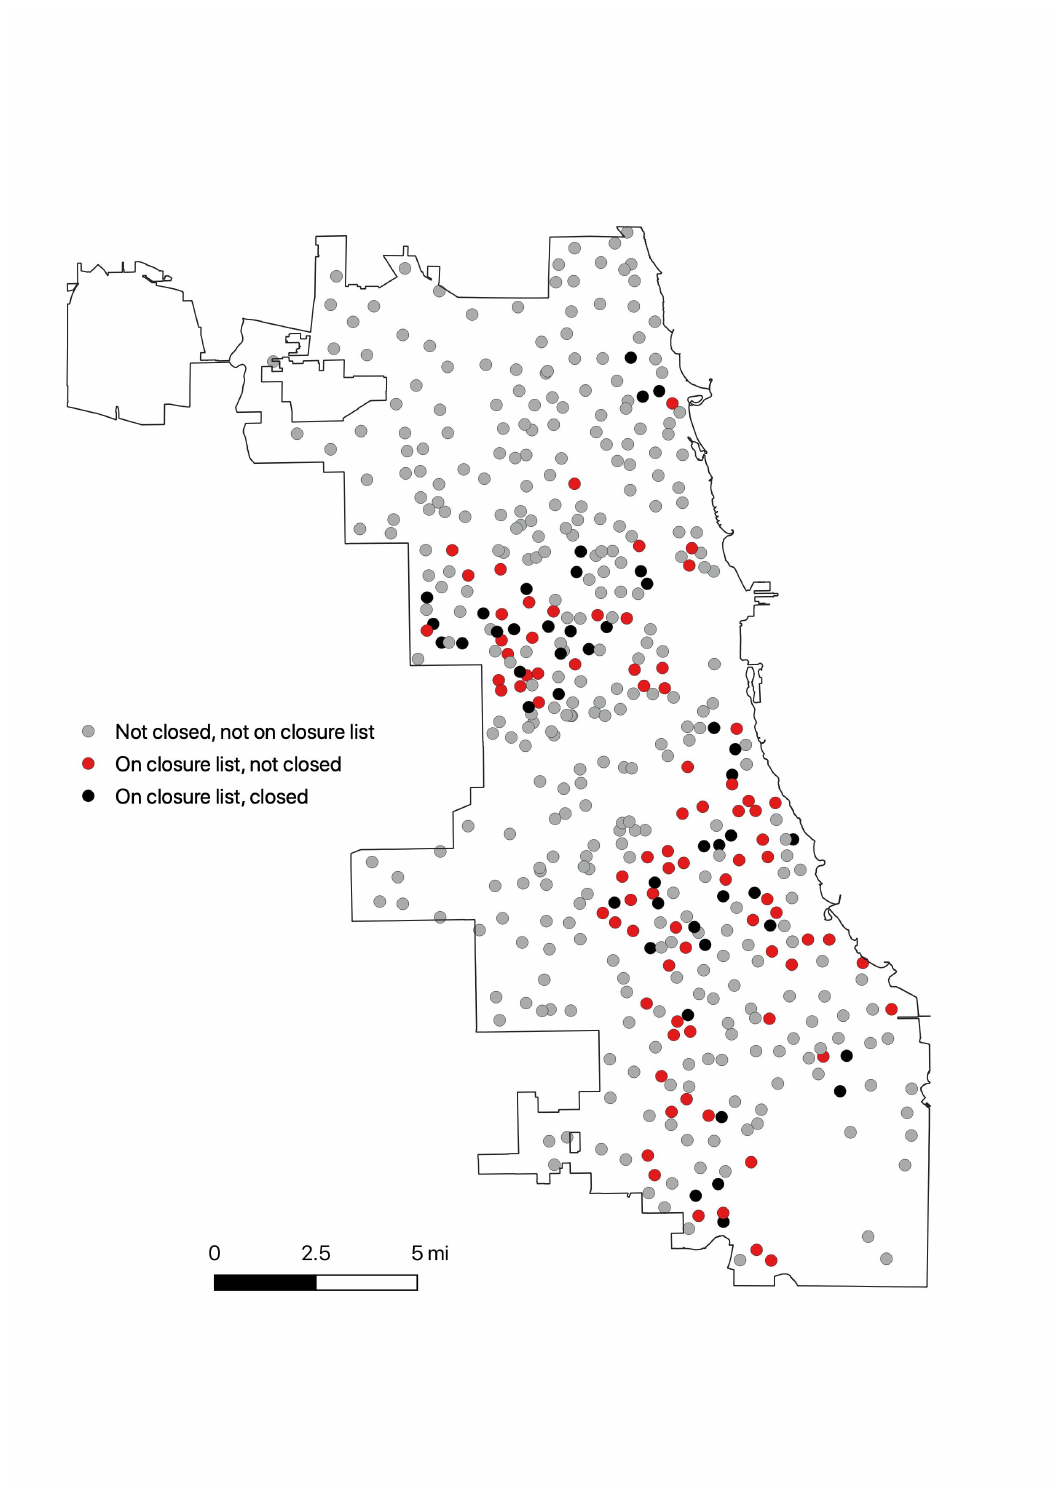
Figure 1: Chicago public elementary school locations in 2013. Mi,